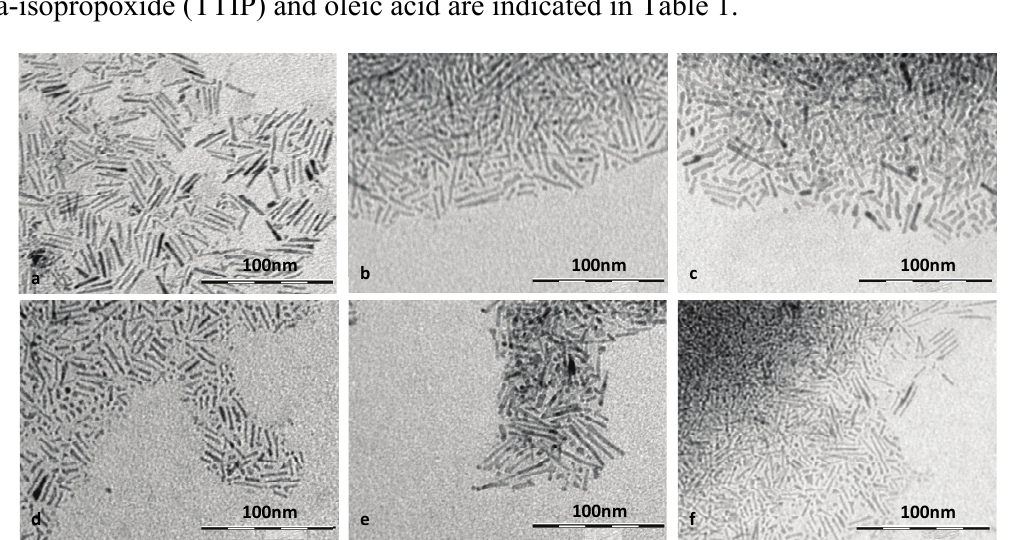
:(B): TOB1 ( a ); TOB2 ( b ); 2